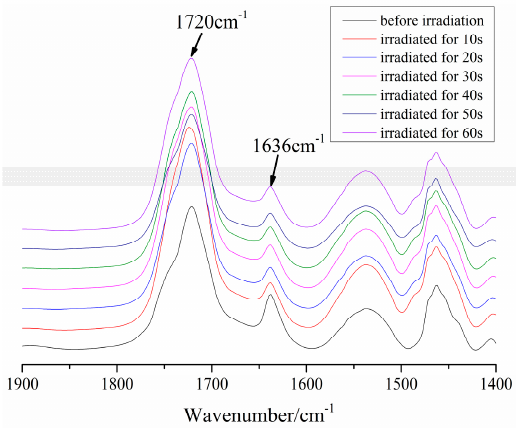
Figure 1. FT-IR spectra during the irradiation process: taking FDMA-based resin as an example.